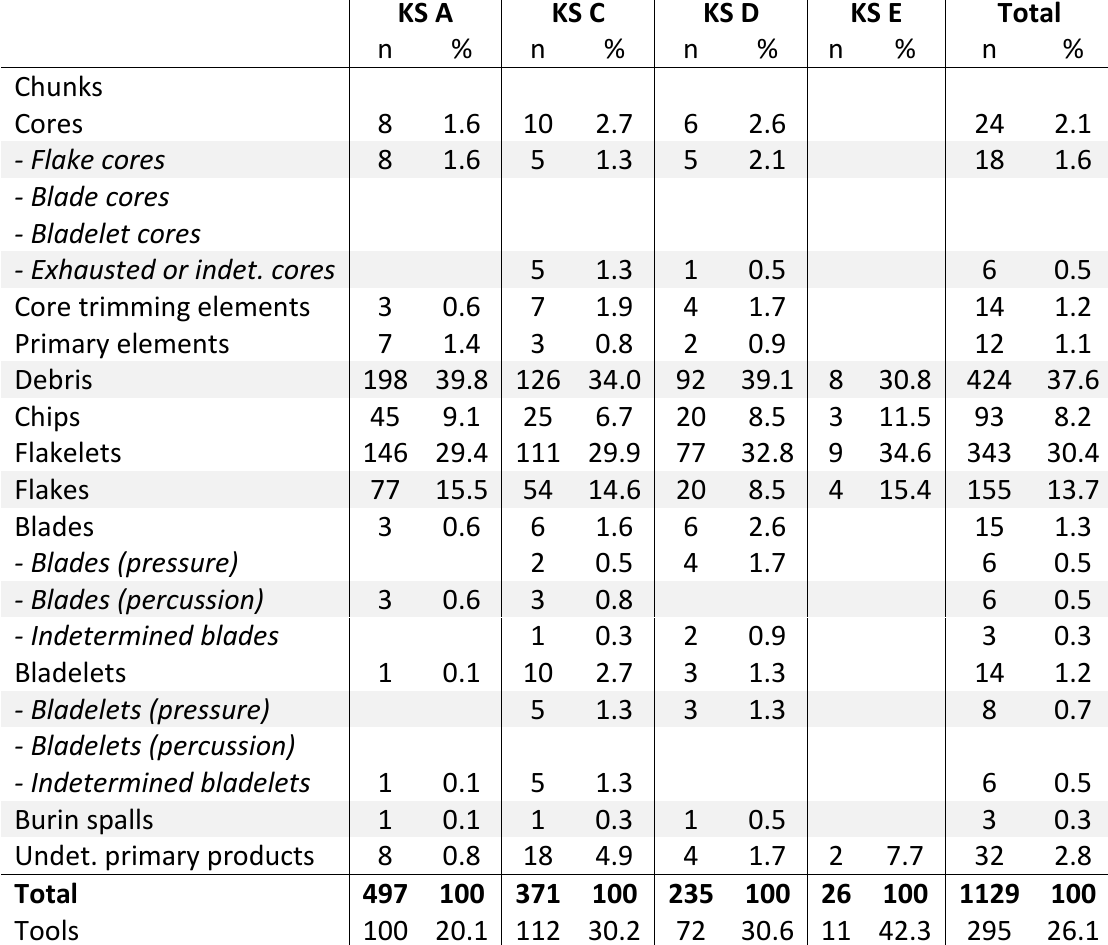
Table 4. Breakdown of primary products at Karmir Sar. Abbreviations: undet. -